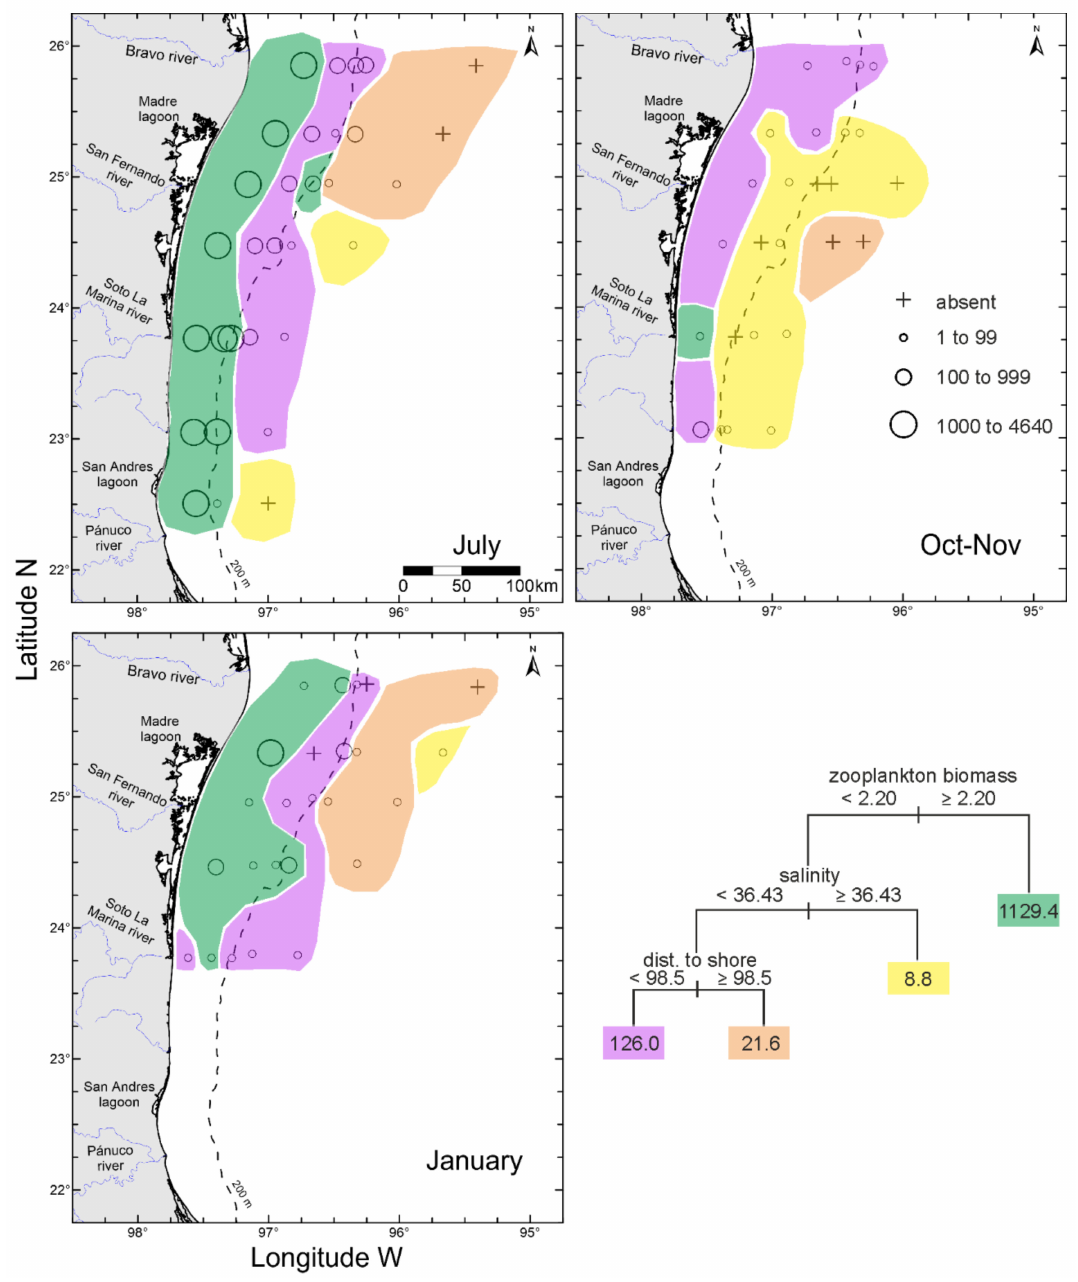
Figure 6. Abundance (ind 100 m − 3 ) of Belzebub faxoni in the western Gulf of Mexico and results of the regression tree analysis showing the mean abundance value of the response variable at the end of the